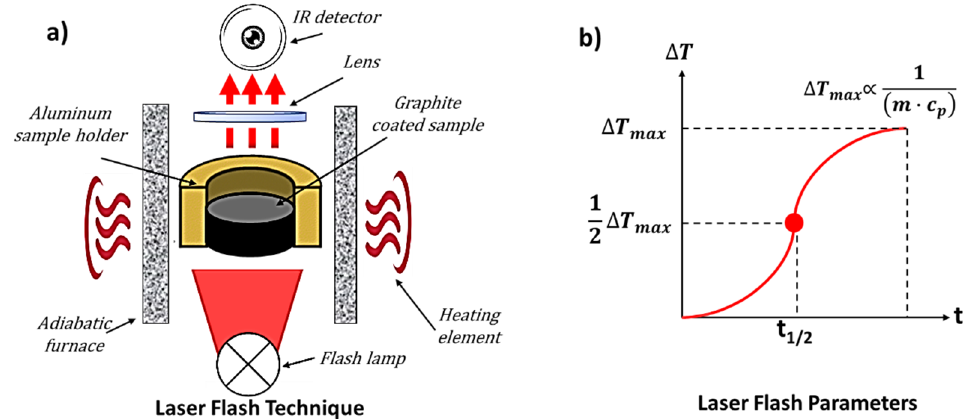
Figure 2. Measurement principle of laser flash method ( a ) and characteristic parameters for the evaluation of the thermophysical properties ( b ).